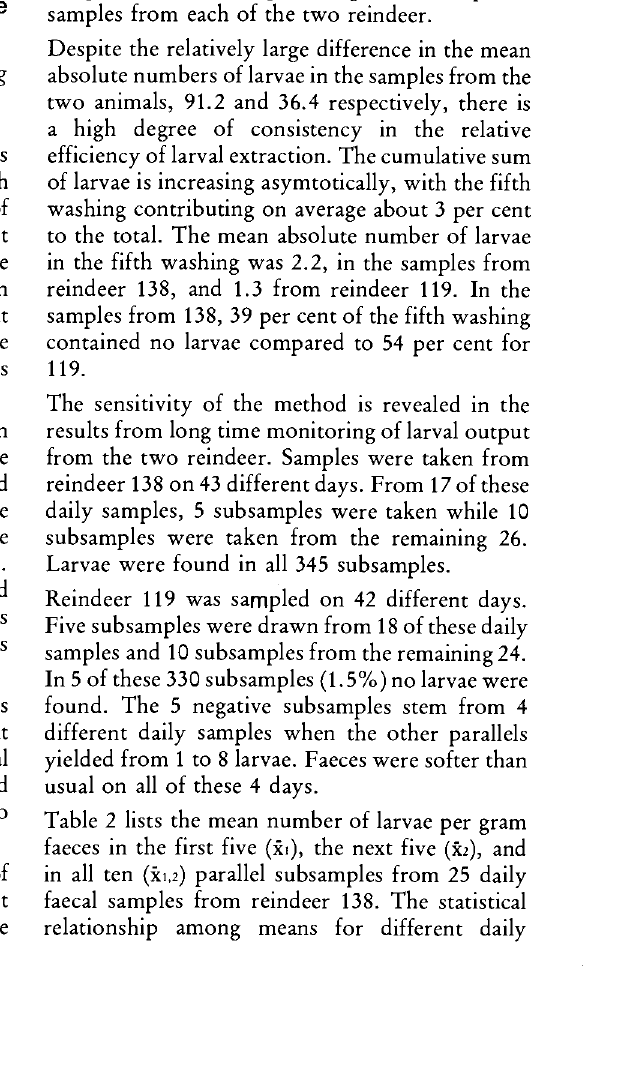
Figure 1. Inverted microscope with photographic attachment and counting